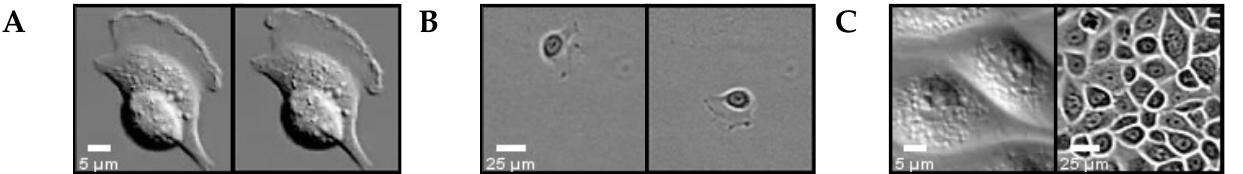
Figure 1. CTMC and wound repair dataset comparison. ( A ) and ( B) : A cell detected in the CTMC ( A ) and wound repair ( B ) dataset in two consecutive frames (left and right panels). Due to higher framerate, the cell displacement in panel ( A ) is almost unnoticeable compared to the cell in panel ( B ) captured at low framerate, which moved far away. ( C) : Equal sized image crops showing the difference in cell density between the CTMC (left) and wound repair dataset (right).